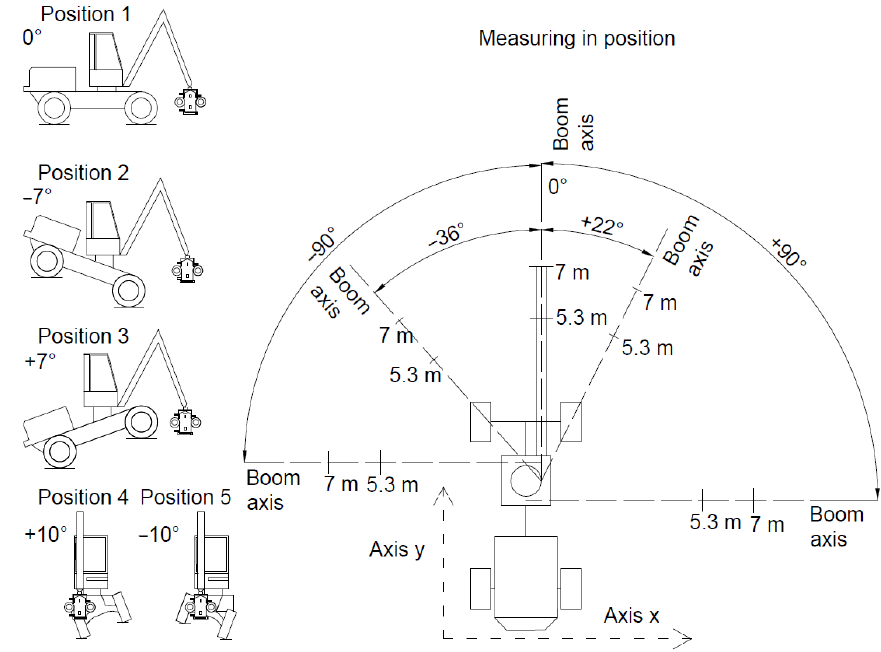
Figure 3. The positions and the system of measuring the center of gravity.